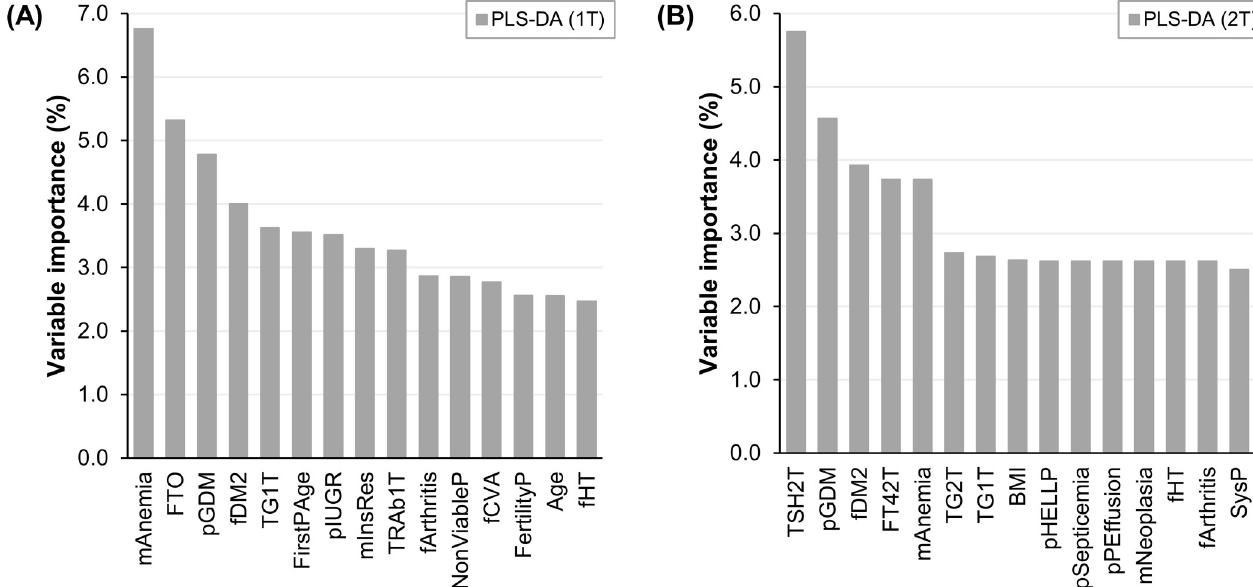
Fig 2. Variable importance of the machine learning models that predict gestational diabetes mellitus with best performance. (A) Built on first trimester data only. (B) Including second trimester data. 1T : First trimester . 2T : Second trimester . PLS-DA : Partial least squares discriminant analysis . mAnemia : Personal anemia . FTO : Fat mass and obesity-associated genotype (rs9939609) . pGDM : Prior gestational diabetes mellitus . fDM2 : Family history of type 2 diabetes . TG : Thyroglobulin . FirstPAge : First period age . pIUGR : Prior intrauterine growth restriction . mInsRes : Personal insulin resistance . TRAb : TSH receptor antibody . fArthritis : Family history of rheumatoid arthritis . NonViableP : Prior non-viable pregnancy . fCVA : Family history of cerebrovascular accident . FertilityP : Fertility problems . fHT : Family history of hypertension . TSH : Thyroid stimulating hormone . FT4 : Free thyroxine . BMI : Body mass index . pHELLP : Prior hemolysis elevated liver enzymes and low platelets syndrome . pSepticemia : Prior septicemia . pPEffusion : Prior pleural effusion . mNeoplasia : Personal neoplasia . SysP : Systolic pressure .